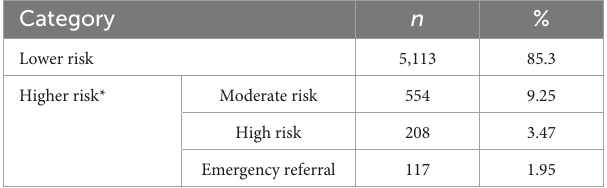
TABLE 2 Categories of